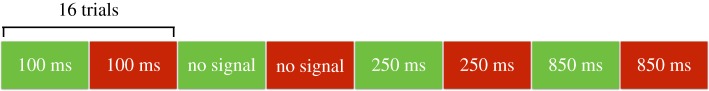
An illustration of the structure of a possible block from the experiment. Green blocks represent sets of eight ‘compatible’ trials, red blocks represent sets of eight ‘incompatible’ trials. The text indicates the SOA condition for each set of trials.